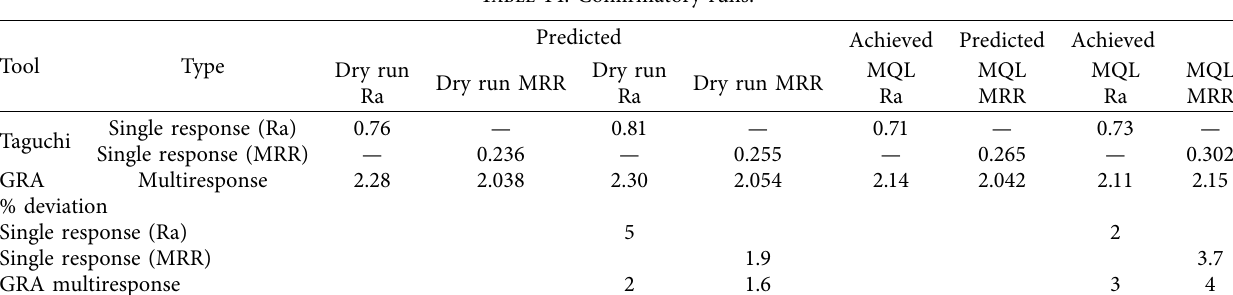
Table 14: Confirmatory